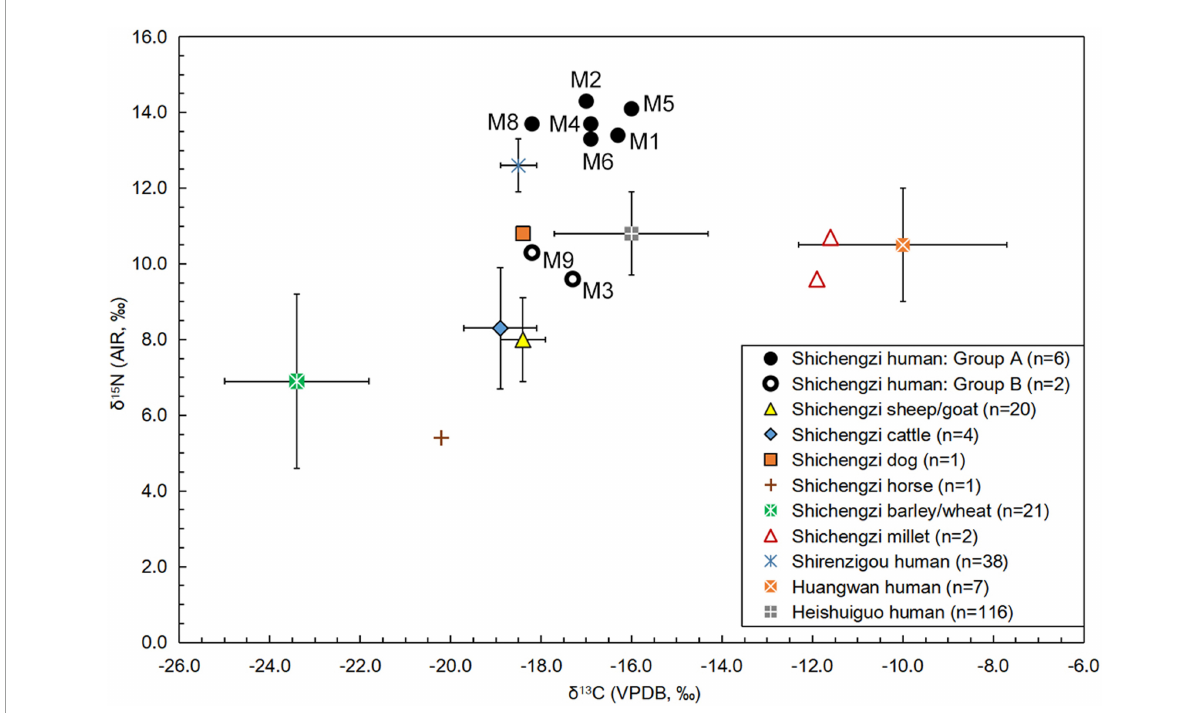
FIGURE2 Stable C and N isotopic data of the crop, animal, and human discovered from the Shichengzi and other three relevant